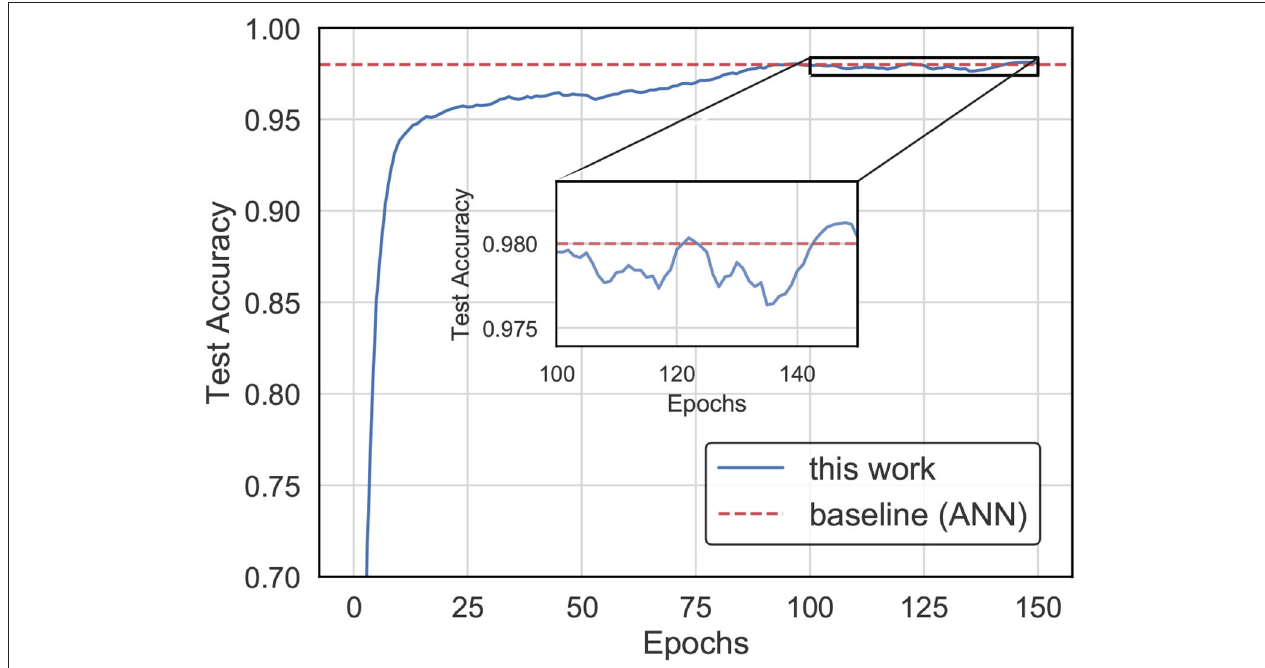
FIGURE 6 | The accuracy evolution curve for training with our method on the MNIST dataset.